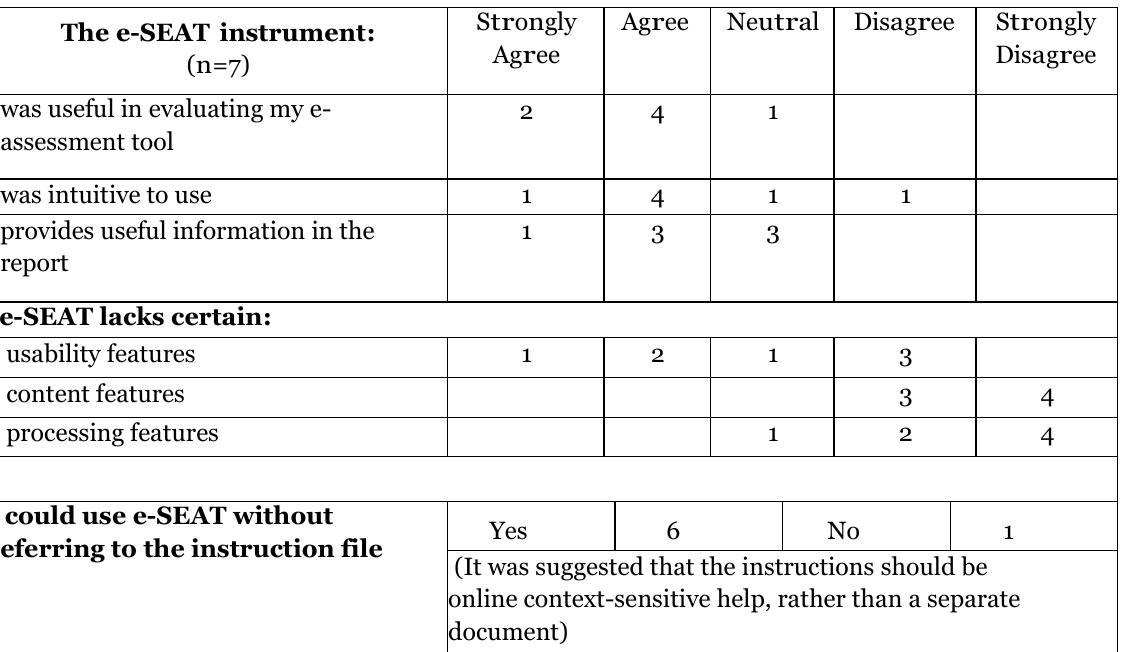
Integration of Ratings from Studies 2 and